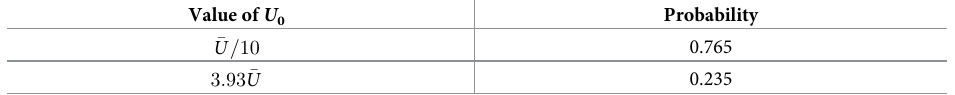
Table 2. Example distribution. The probability distribution here has that the mean U 0 value is � U and the standard- deviation to mean ratio is consistent with